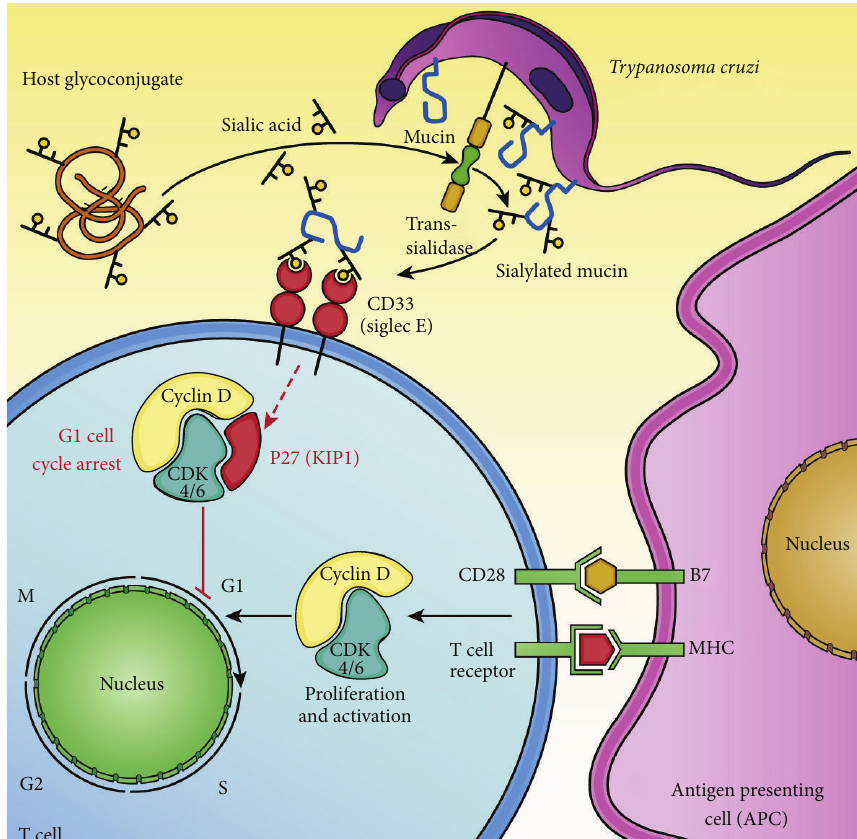
Figure 1: Model depicting the inhibitory effect of Trypanosoma cruzi sialoglycoproteins on T cell activation. Schematic diagram showing the sialylationofO-linkedoligosaccharidesofmucin-derivedtrypomastigotesmediatedbythesurface-associated T.cruzi parasitetrans-sialidase. Theparasitetrans-sialidase,whichcanalsobeshedintothebloodstreamortissueinterstitiumaftercleavageofitsglycosylphosphatidylinositol (GPI) anchor by the action of a phosphatidylinositol-phospholipase C, transfers sialic-acid residues from host glycoconjugates to parasite mucins. It has been demonstrated in other studies that the T. cruzi parasite-derived mucins bind to mammalian host cell receptors such as the acid-binding Ig-like lectin receptor Siglec-E (CD33) and undermine host defence mechanisms. In CD4 + T cells, we showed that the Siglec-E receptor inhibits the mitogenic responses upon T cell receptor stimulation. The initiation of the G1 to S transition during antigenic/mitogenic T cell expansion is mediated by cyclin D and cyclin-dependent kinases CDK2 or CDK6, which are induced and together initiate the G1/S transition. We have shown that the G1/S transition is significantly inhibited by the sialyl terminal residues of T. cruzi mucins and we propose that this phenomenon is mediated by its interaction with the Siglec-E receptor. The interaction of CD4 + T cells with the sialylated form of the parasite mucin leads to induction of p27/Kip1, a member of the family of CDK inhibitors that negatively regulate the G1 to S transition, so damping T cell-mediated immune responses by inducing T cell cycle